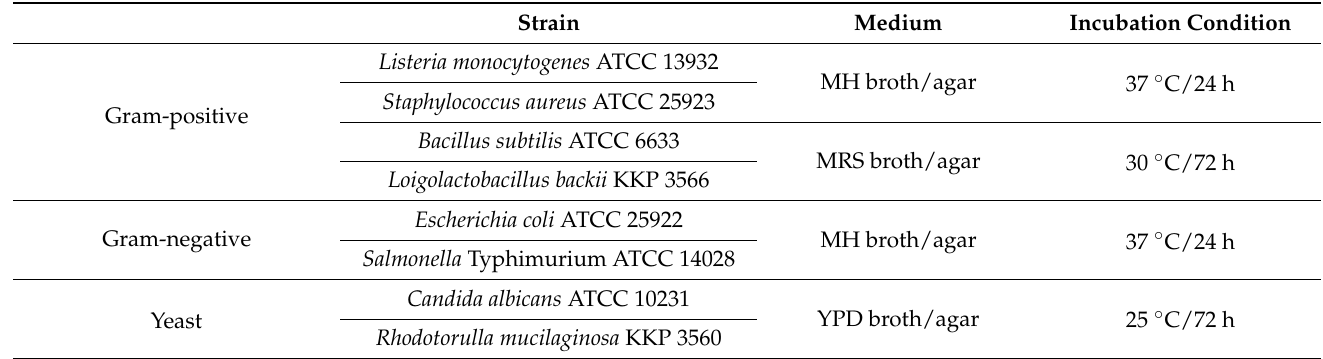
Table 9. The type of medium and growth conditions used for tested